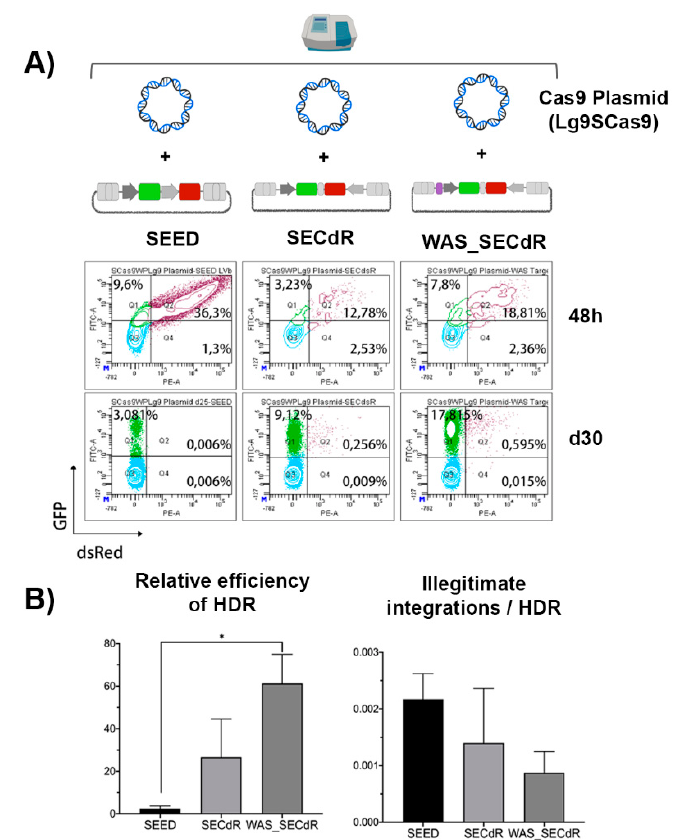
Figure 5. E ffi cacy and specificity of HDR in K562GWP cell line with di ff erent donor templates. ( A ) Representative cytometry plots showing the expression of eGFP (FITC-A) and dsRED (PE-A) in 13-K562GWP cells over time. Each of the donor templates (SEED, SECdR or WAS_SECdR), as well as the CRISPR / Cas9 system, was transferred to the target cells as plasmids by co-nucleofection. The expression of eGFP and dsRED was determined 48 h post-nucleofection, and 30 days later. ( B ) Graphs showing the relative HDR e ffi cacy and specificity of HDR-GE for the di ff erent DNA donors. The relative e ffi cacy of HDR (left graph) was calculated by dividing the % of eGFP + dsRED- cells (on-target HDR) at day 30 by the % of double positive cells at 48 h (initial transfection e ffi cacy). Right graph shows the frequency of illegitimate integration related to the e ffi cacy of HDR. Values represent mean of three separate experiments and the error bars indicates the standard errors of the mean. The comparison between the di ff erent groups was carried out using the Mann-Whitney U test (* p <